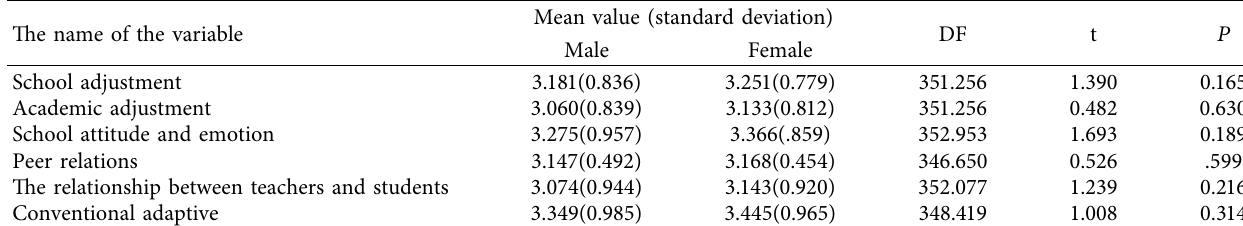
Table 4: Summary of school adaptation difference analysis of middle school students of different